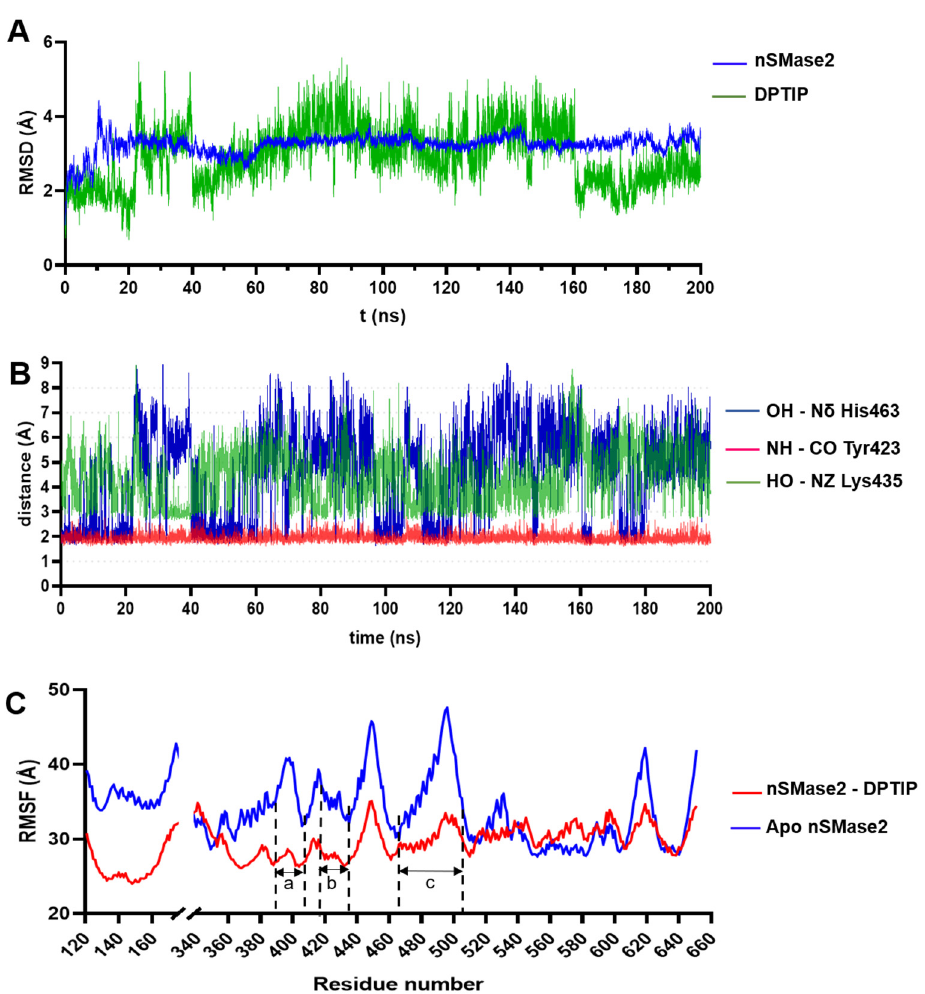
Figure 5. RMSD, critical distances, and RMSF for nSmase2-DPTIP binding based on the MD simula- tions. ( A ) RMSD plot the nSMase2-DPTIP complex during the MD simulations. ( B ) Evolution of the distance of DPTIP-OH-N δ -His463, DPTIP-NH-CO Tyr423, and DPTIP-OH-NZ Lys435 along the MD simulation. ( C ) RMSF plot of protein residues during the MD simulations of the nSMase2-DPTIP complex and apo protein.